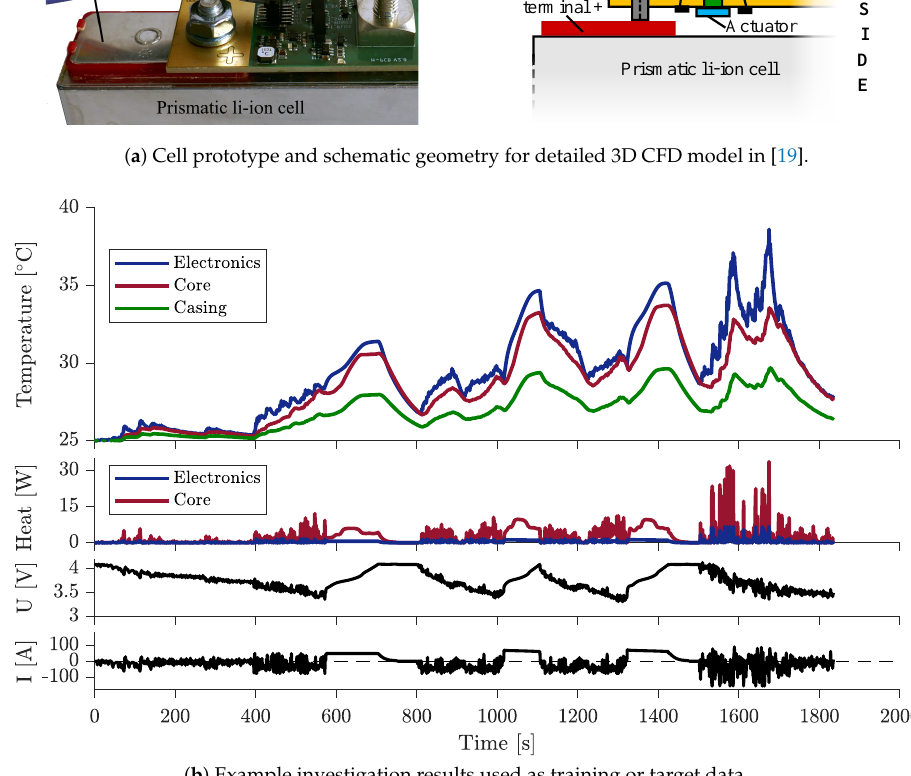
Figure 2. Reference system based on our previous investigation [19]: ( a ) Cell prototype with electron- ics and corresponding schematic geometry for the detailed 3D spatially dependent electro-thermal CFD model. ( b ) Example results for the temperature and heat generation behavior of the prototype cell for 25°C starting temperature. Various comparable datasets in the range of 15–45°C are used as a training or target